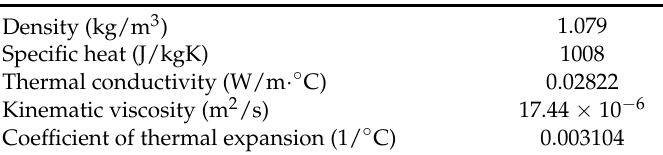
Figure 9. The positions of the air gaps in the simulation models. Table 4. The thermal properties of the air gap.